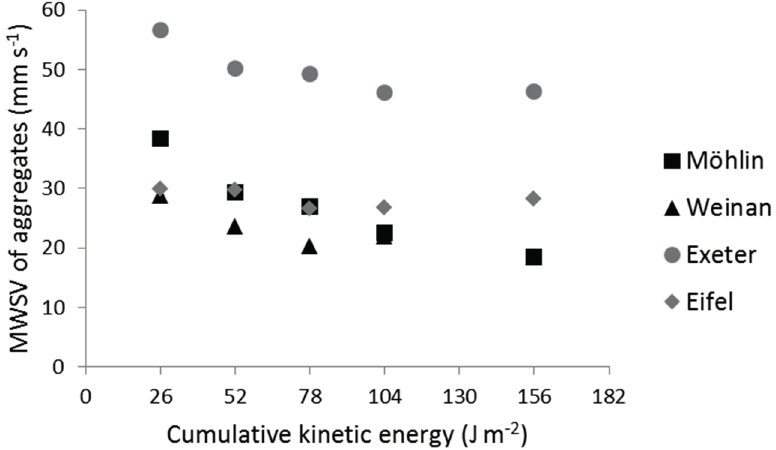
Figure 4. Mean Weight Settling Velocity (MWSV) of aggregates as cumulative kinetic energy increased.